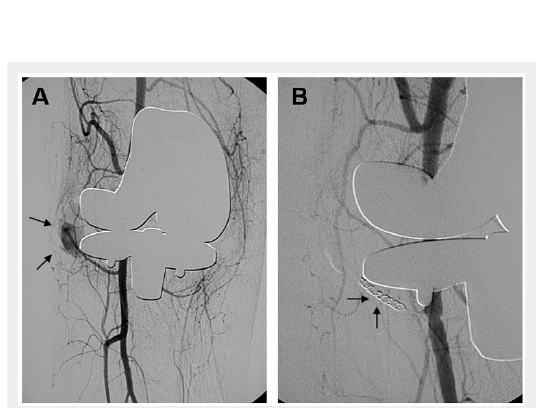
Angiographic photographs showing a false aneurysm of the inferior medial popliteal artery of the right knee (a) before and after intervention via coiling (b).